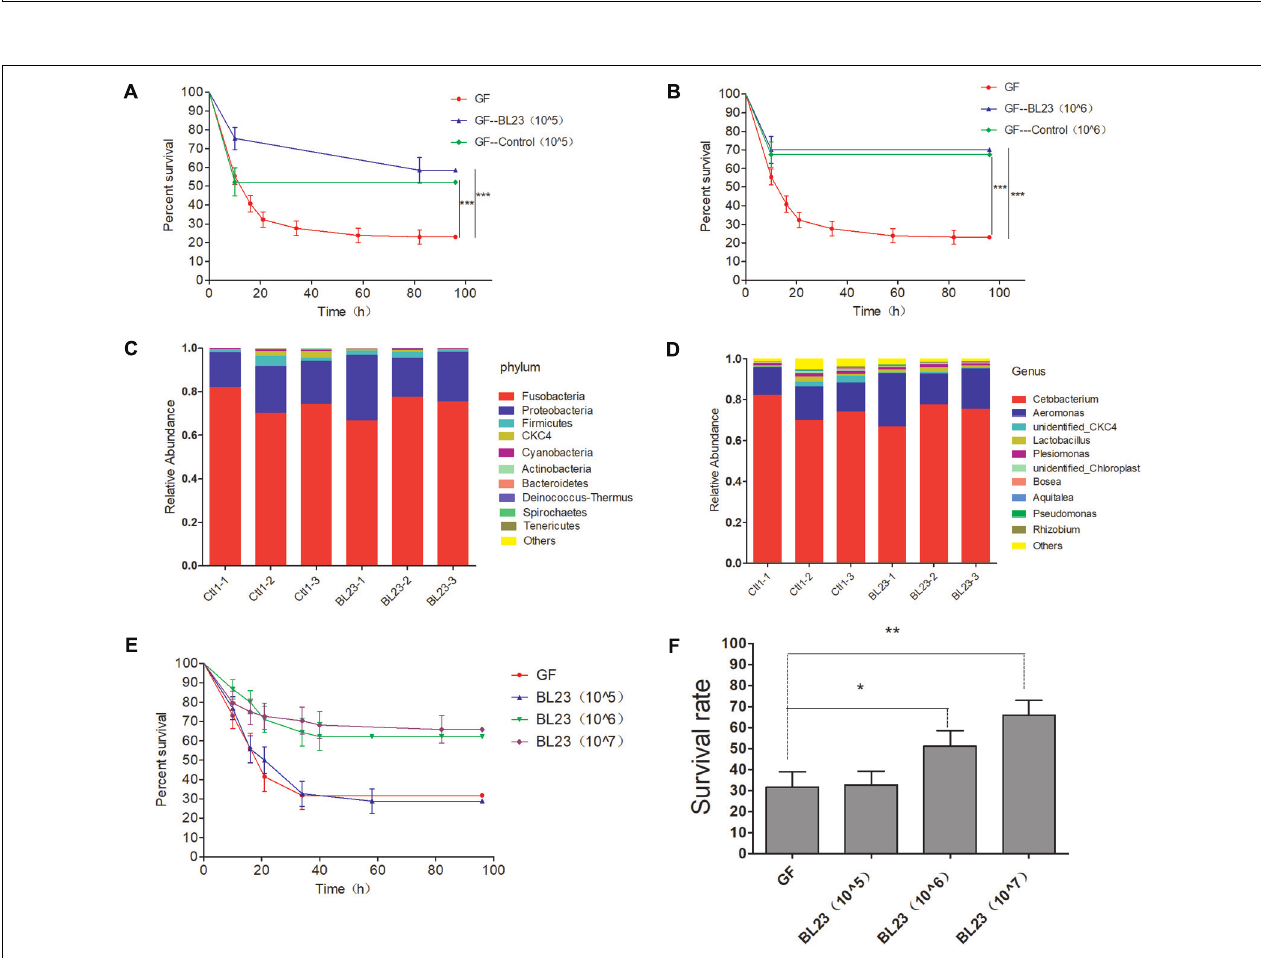
FIGURE 2 | The protection of L. casei BL23 was mediated by the bacteria itself and does not involve intestinal microbiota of host. The survival rate of GF zebrafish larvae colonized with gut microbiota from control or L. casei BL23 treated fish at a dose of 10 5 CFU/mL (A) and 10 6 CFU/mL (B) after infected with A. veronii . Gut microbiota of zebrafish from control or L. casei BL23 treated fish at phylum (C) and genus (D) level. The survival rate (E) and final survival rate (F) of GF zebrafish larvae treated with L. casei BL23 at a dose of 10 5 , 10 6 , and 10 7 CFU/Ml, respectively after infected with A. veronii . Asterisks indicate significant difference compared with control ( ∗ P < 0.05, ∗∗ P < 0.01, ∗∗∗ P < 0.001).